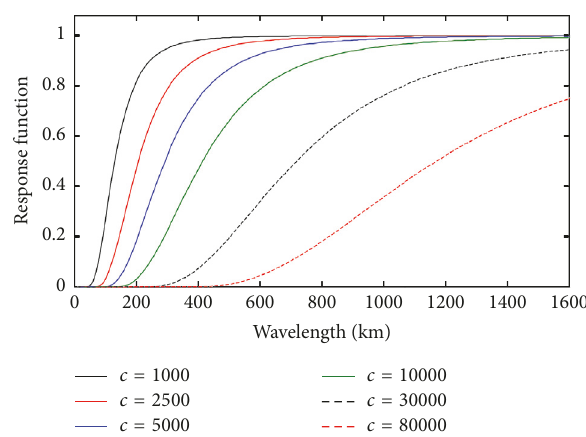
Figure 2: The response function of Barnes filter for different para- meters 𝐶 when 𝐺 = 0.35